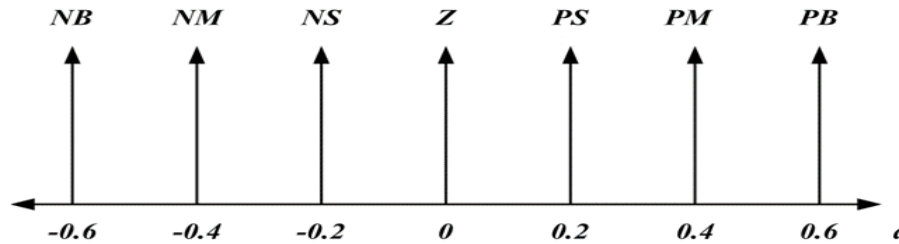
Figure 3. Output membership functions based on singleton (CoG).